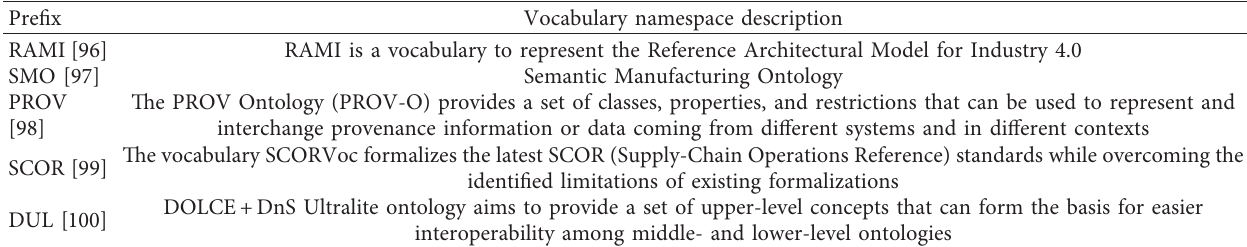
Figure 13: Technology and cost-related factors of a wire harness manufacturing visualised on the theoretical ontology. Table 2: List of the integrated ontology